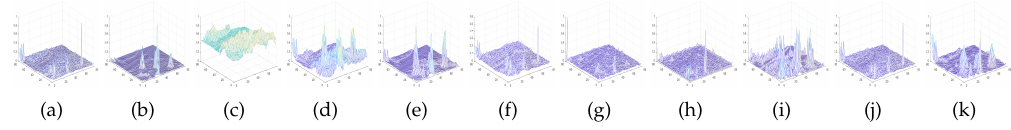
Figure 13. Three-dimensionalplots of the detection results for the San Diego dataset. ( a ) GRX; ( b ) BJSRD; ( c ) LSAD; ( d ) LRASR; ( e ) LSMAD; ( f ) CBAD; ( g ) CRD; ( h ) LRX; ( i ) LKRX; ( j ) OSP; and ( k )